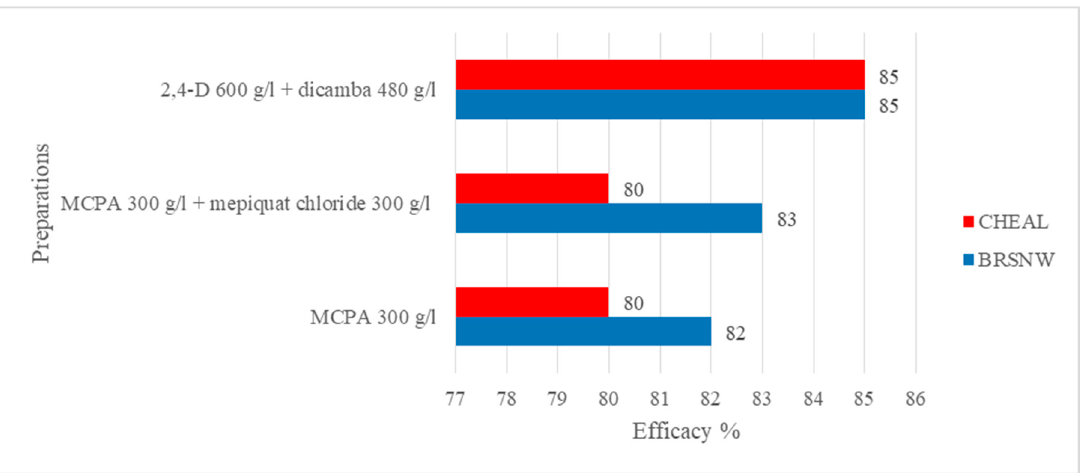
Figure 1. Evaluation of herbicide efficacy against Chenopodium album L., and Brassica napus L (no significant differences).